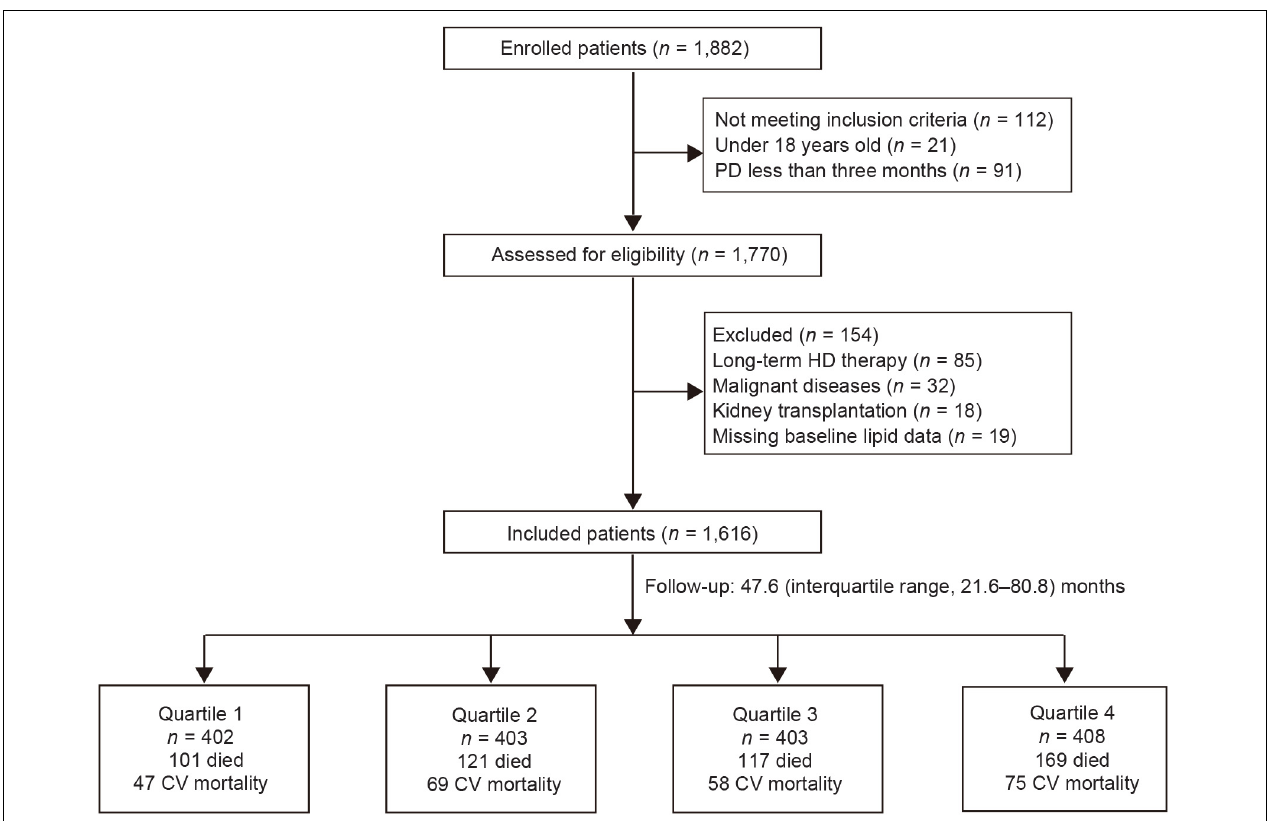
FIGURE 1 | Flow chart for the study. CV, cardiovascular; HD, hemodialysis; PD, peritoneal